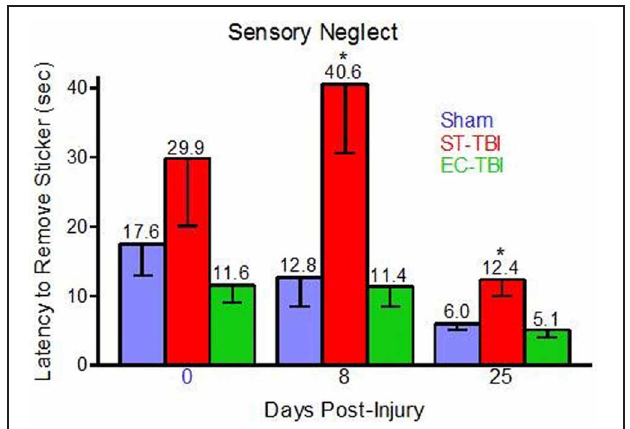
FIGURE 3 | Reduced sensory neglect deficit associated with enrichment before injury. Sham and EC-TBI animals removed the stickers significantly faster than the ST-TBI group at days 8 and 25 post-injury. Data shown are Mean − SE. ∗ Significantly different than Sham and EC-TBI using Tukey’s post-hoc